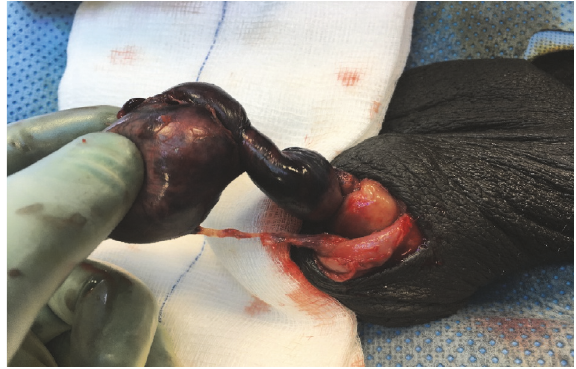
Figure 2: Black, torsed left testis attached with old stitch from lower pole to the side wall of scrotum.